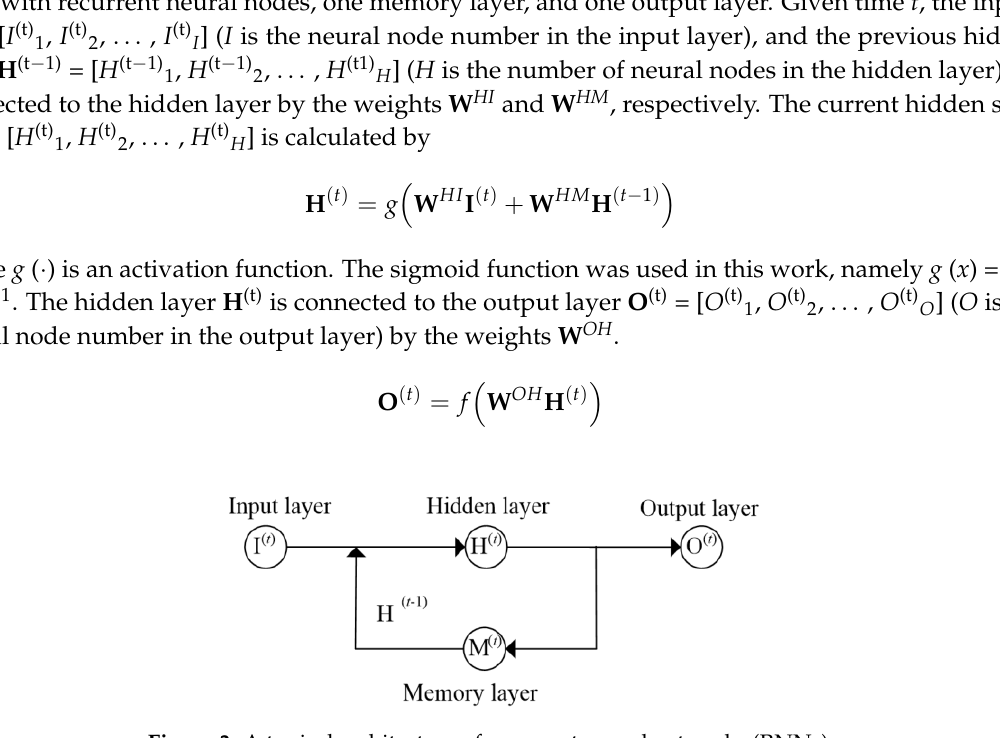
Figure 3. A typical architecture of recurrent neural networks (RNNs).